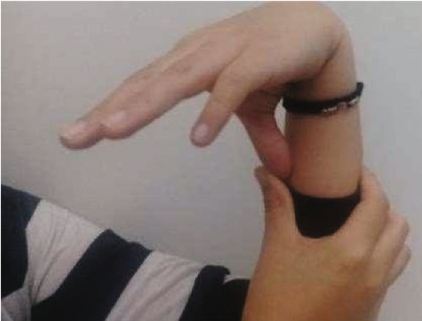
Figure 1: Hyperlaxity in the thumb.